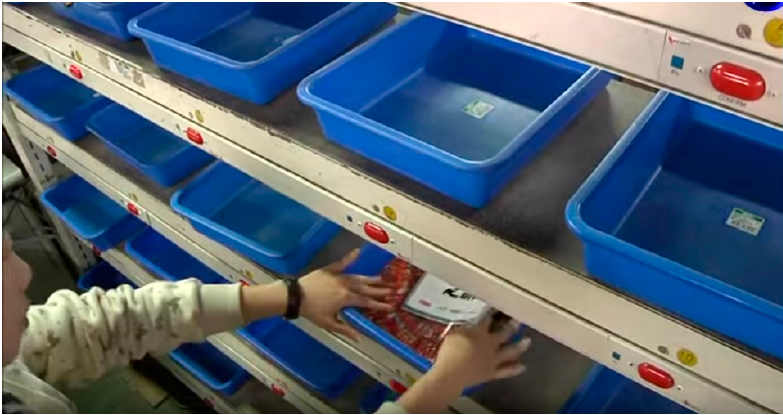
Figure 2. Order sortation process.